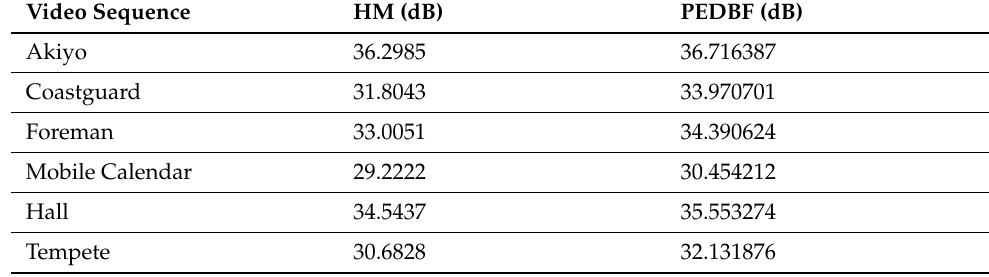
Table 6. PSNR of CIF video sequences with QP = 37.